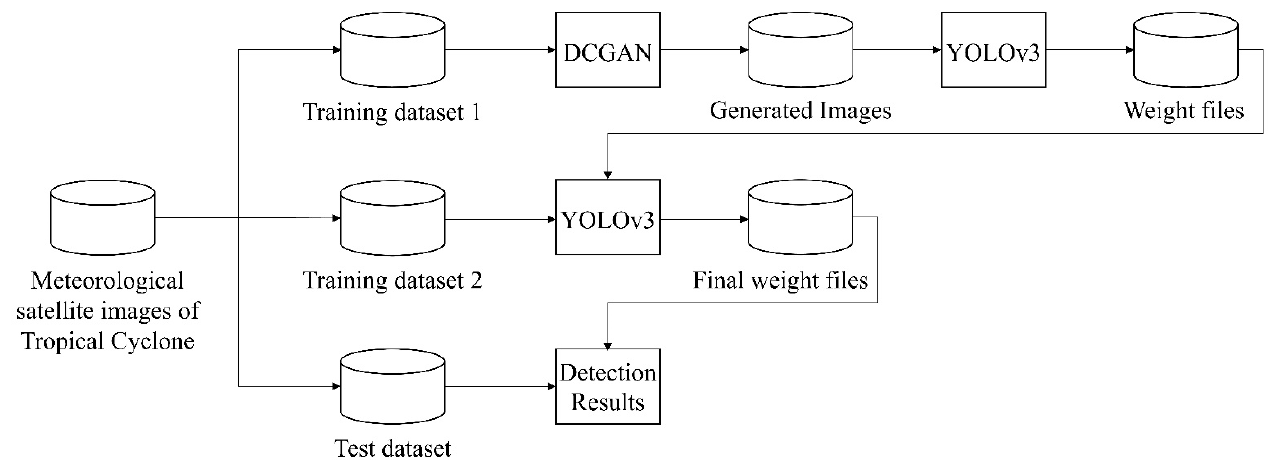
Figure 1. Overview of the proposed new detection framework of tropical cyclones (NDFTC).